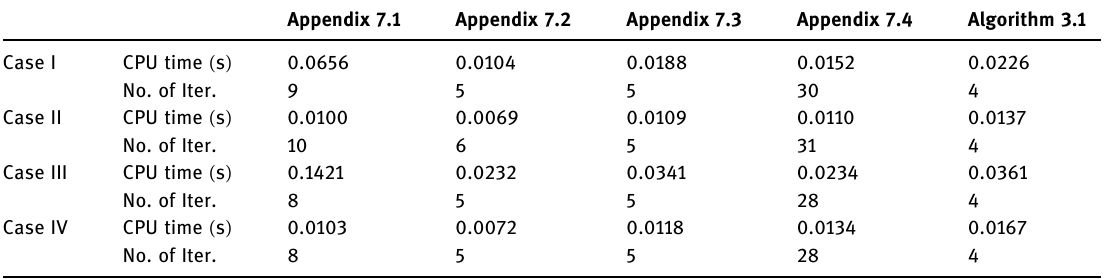
Table 1: Numerical results for Example